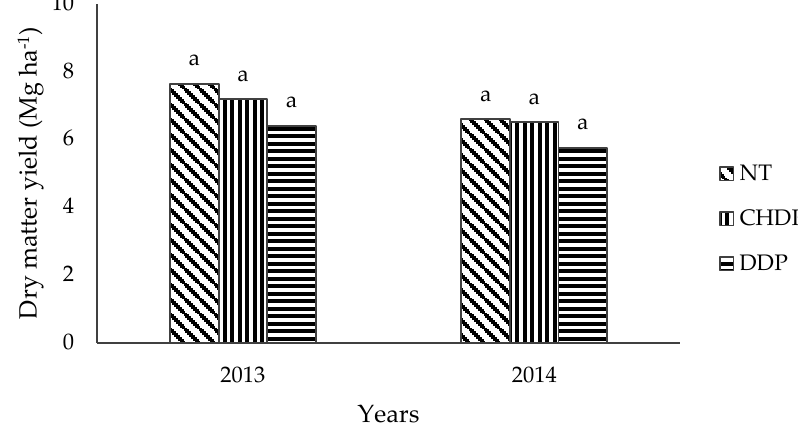
Figure 10. Dry matter yield of maize for the three tillage systems in the seasons 2013 and 2014. Mean values with the same letter in the same year are not significantly different (Tukey, α ≤ 0.05) .